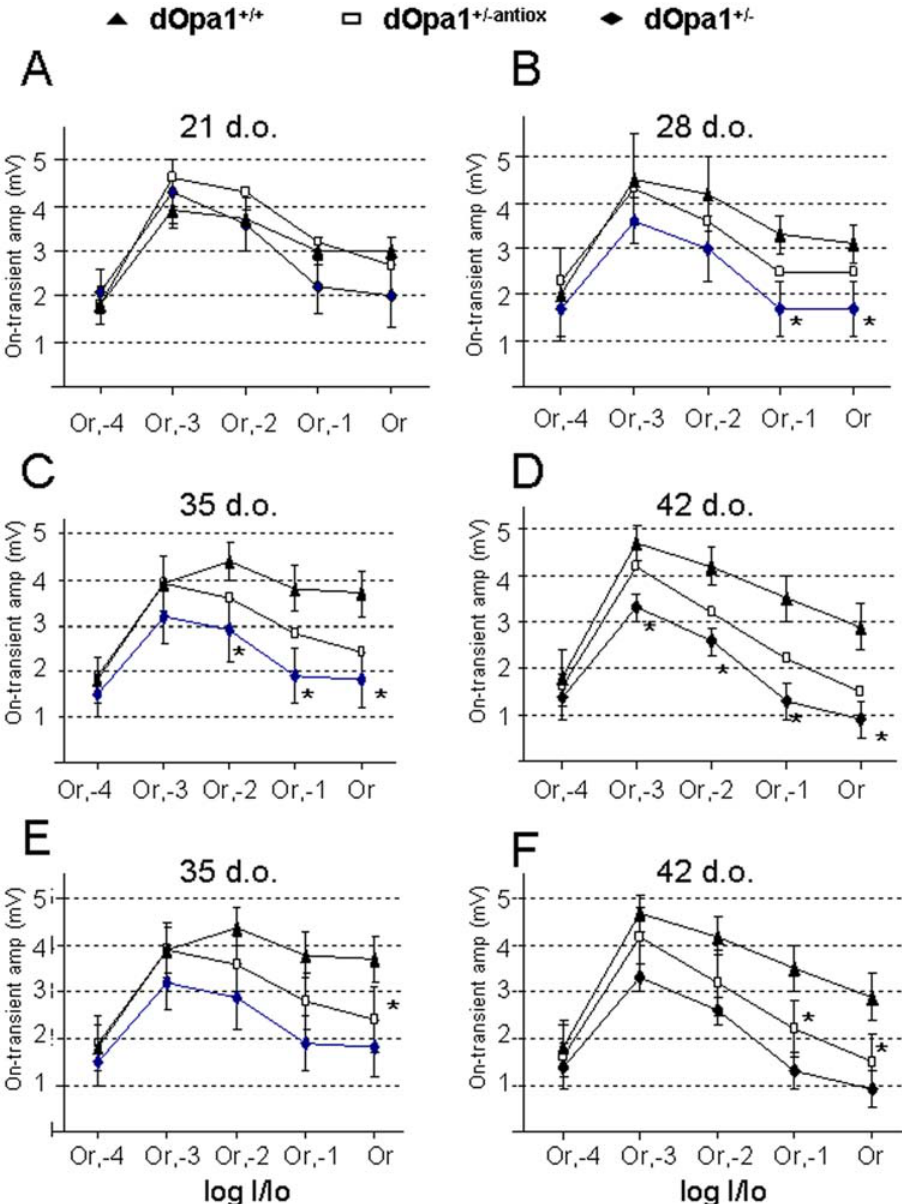
Figure 2. Heterozygous dOpa1 mutation causes a progressive reduction in on-transient amplitudes in an age-dependent manner and antioxidants can reduce the progression. (A) dOpa1 + / 2 shows no significant reduction in on-transient amplitudes when compared to dOpa1 + / + at 7 to 21 d.o. (shown are the 21 d.o. data). dOpa1 + / 2 shows significant reductions in on-transient amplitudes with the Or,-1 and Or stimuli at 28 d.o., (B) and with Or,-2, Or,-1, and Or stimuli at 35 d.o. (C), and at all Or light stimuli except the very dim Or,-4 at 42 d.o. (D) Antioxidant fed dOpa1 + / 2 shows an increase in the mean on-transient amplitudes (A–D), but the increase is not significant when compared to dOpa1 + / 2 (E & F, with error bars shown.). When compared to dOpa1 + / + , at 35 d.o. antioxidant fed dOpa1 + / 2 shows a significant reduction in on-transient amplitudes only with the Or stimulus (E), but not with Or,-2, and Or,-1 as in dOpa1 + / 2 (C). At 42 d.o. dOpa1 + / 2 antiox shows a significant reduction in the on-transient amplitudes only with Or,-1 and Or (F), but not with Or,-3, and Or,-2 as in dOpa1 + / 2 (D). Or=Or light stimulus; Or, -1=Or light stimulus with a log I/Io=-1 filter to reduced the orange light intensity by 10 fold; Or, -2=Or light stimulus with intensity reduced by 100 fold, Or, -3=1,000 fold reduced Or light stimulus, and Or, -4=10,000 fold reduced Or light stimulus. doi:10.1371/journal.pone.0006867.g002 in dOpa1 + / 2 heterozygous mutants with a phototaxis assay. This assay plate showing little visual phototatic response (RI=0.248), while wild- allowed us to measure larval visual phototactic response to light type dOpa1 + / + exhibited strong negative phototactic behavior (Figure 3A). Fifty second-instar larvae were tested in three trials. In the (RI=0.616, p , 0.05) (Figure 3B). These results were replicated using absence of light, average response indexes (RI) for dOpa1 + / + and both dOpa1 + /ex2 and dOpa1 + /in3 Drosophila as discussed in our earlier dOpa1 + / 2 were similar (RI=0.072, RI=0.096, respectively, p . 0.05) paper [18]. Our results suggest that heterozygous mutation of dOpa1 causes loss of visual acuity in Drosophila . This observation is consistent (Figure 3B). However, with light, dOpa1 + / 2 mutants scattered on the